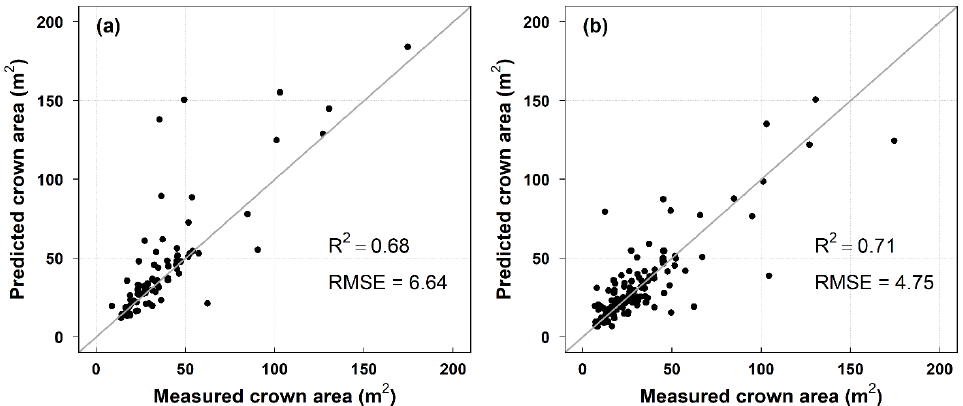
Figure 7. Relationships between the measured tree crown areas and the predicted tree crown areas from the pre-trained ( a ) and transfer-trained ( b ) Detectree2 methods. The gray, solid line represents the 1:1 line.